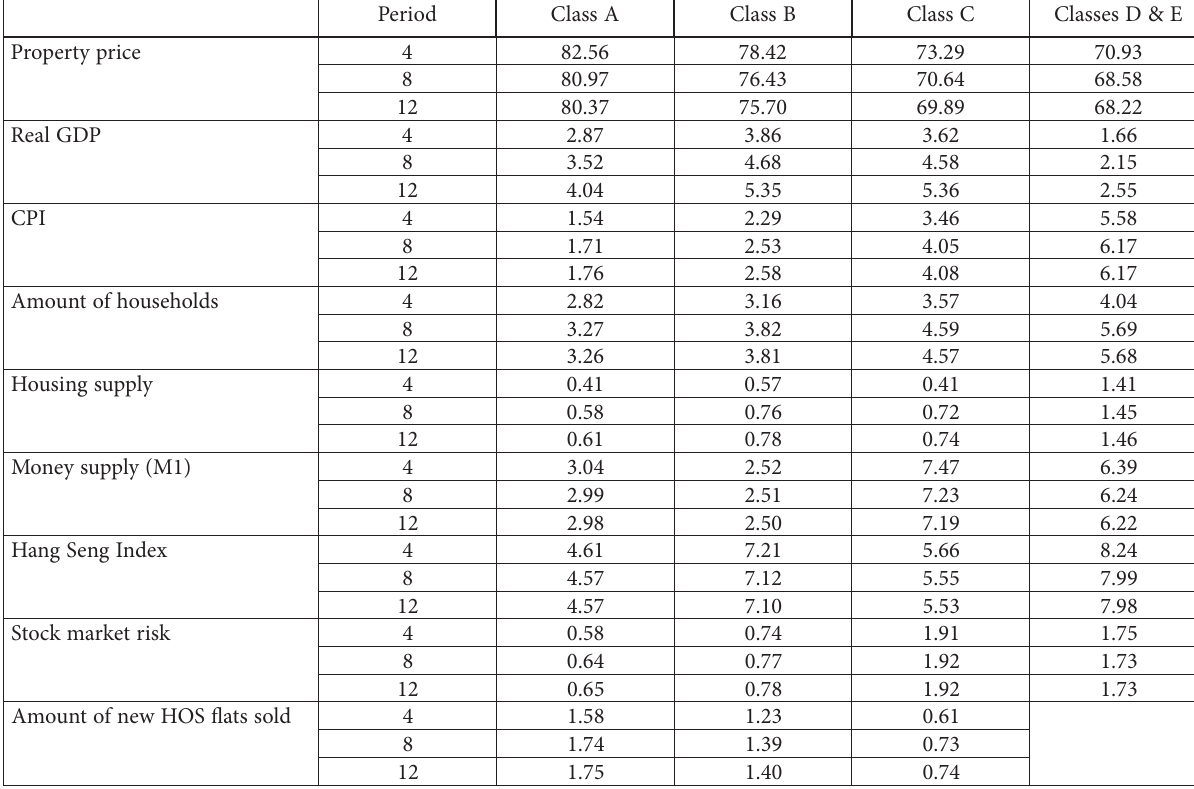
Table 3. Variance decomposition analysis results (Property price indices; in %)